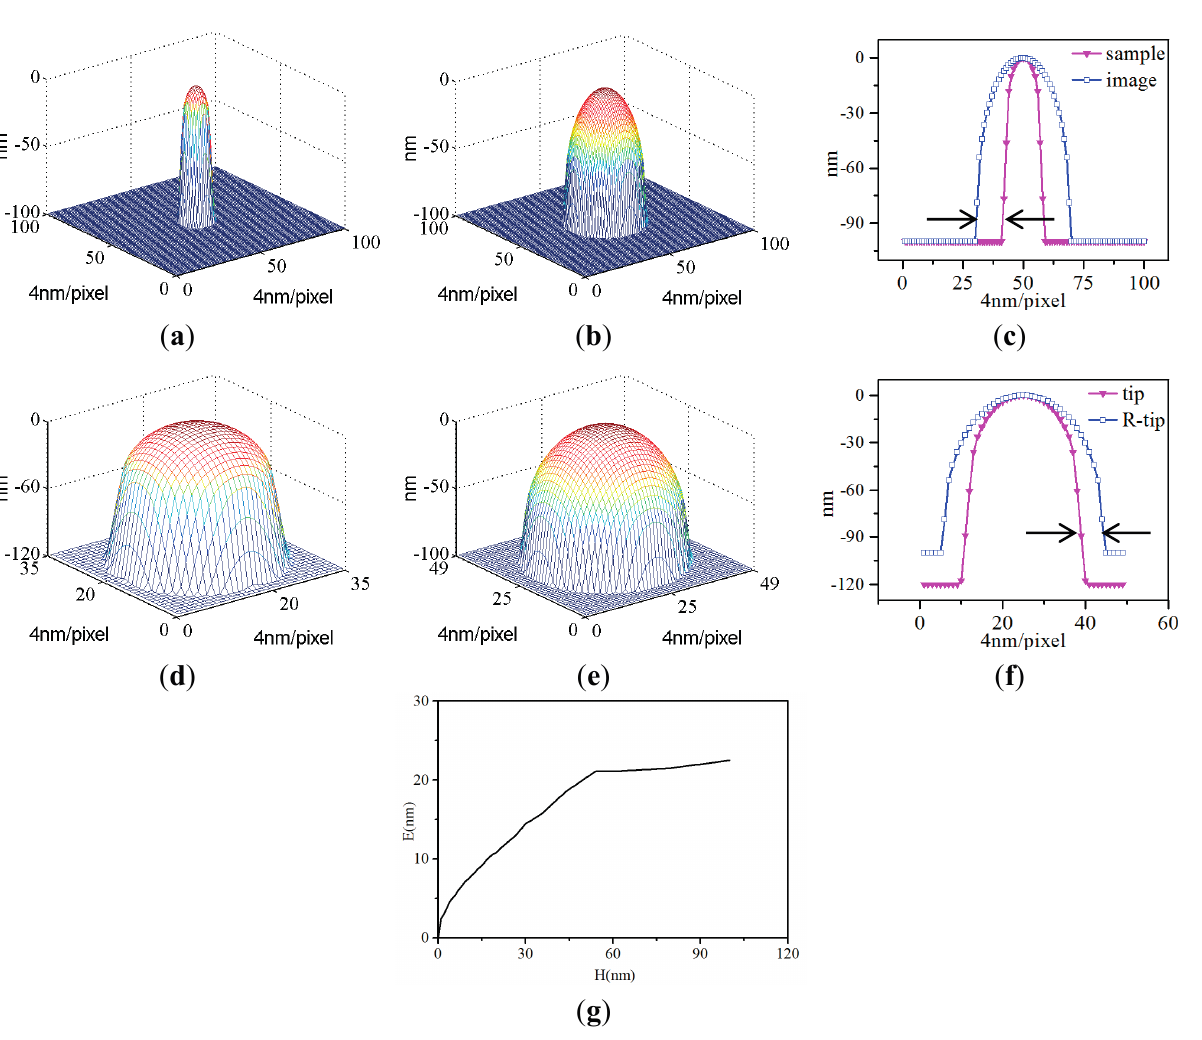
Figure 3. An example of simulated experiments using the Blind Tip Reconstruction (BTR) method. ( a ) A simulated 3D sample surface; ( b ) An image obtained by dilating sample surface with the simulated tip; ( c ) Comparison of cross sections through the apex of the sample and image; ( d ) A simulated 3D tip; ( e ) A reconstructed 3D tip produced by using the tip and reconstructed tip; ( g ) The deviations between the actual tip and the reconstructed